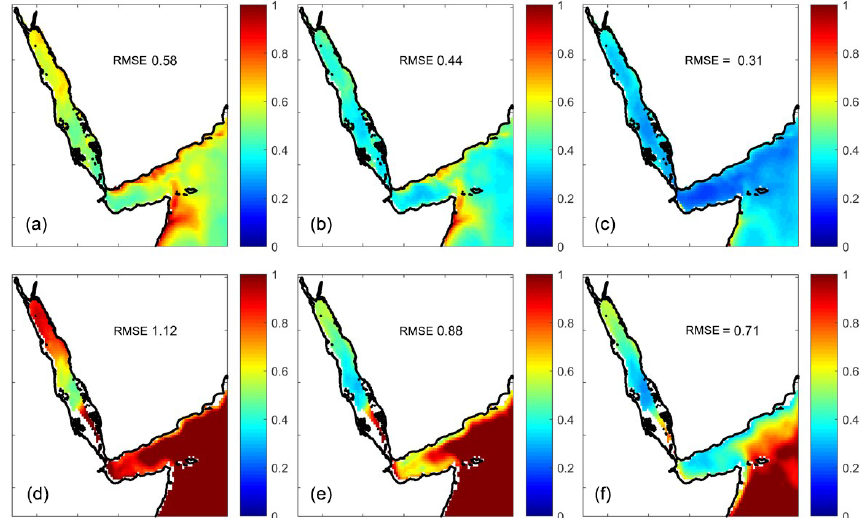
Figure 8. Horizontal distribution of the RMSE (in ◦ C) of the background (a, d) , OI (b, e) and formal error (c, f) . The results are shown for 7m depth (a–c) and 125m depth (d–f)